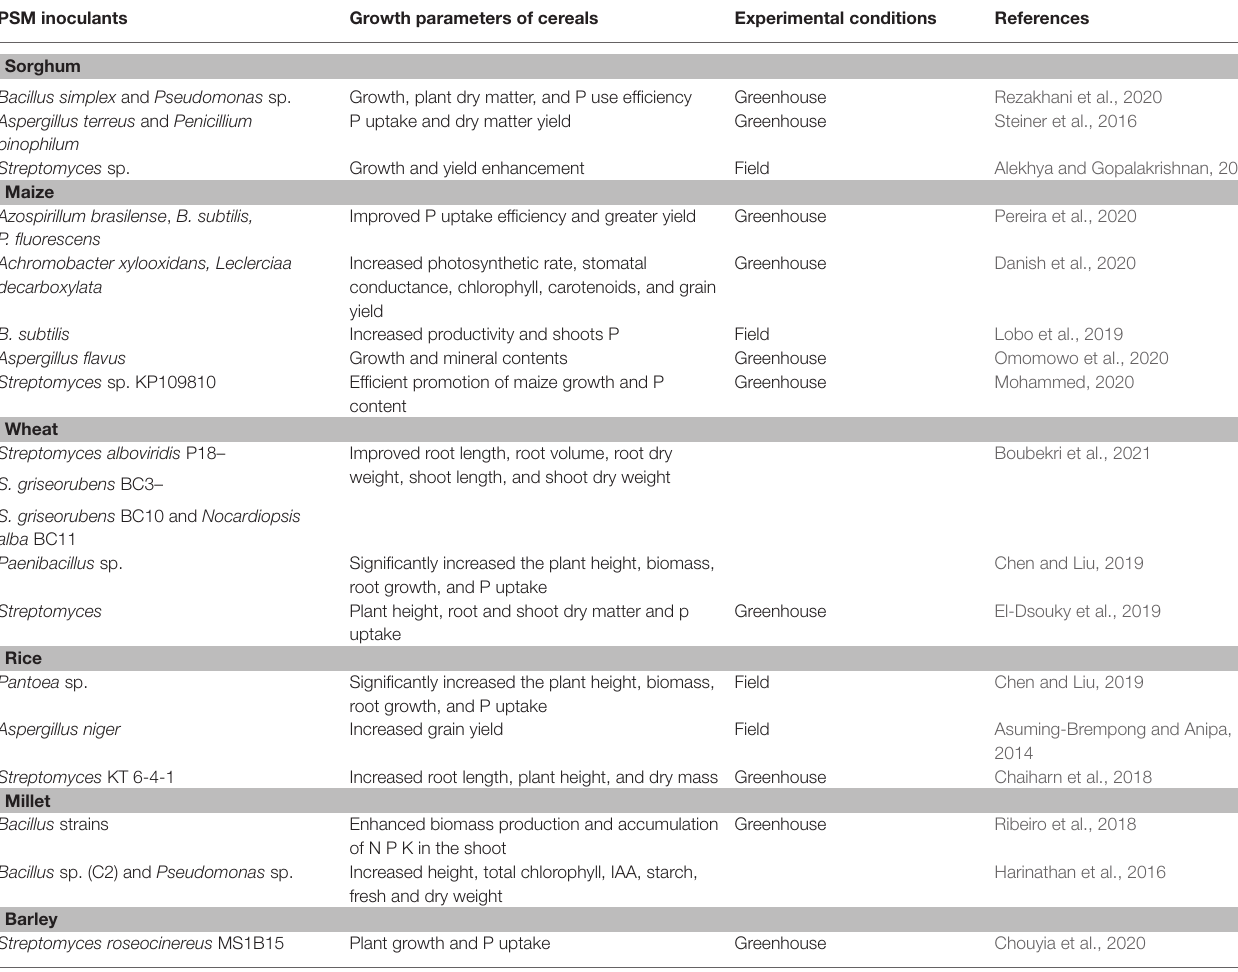
TABLE 4 | Inoculation effects of PSM on the performance of cereal crops grown in different agroecological